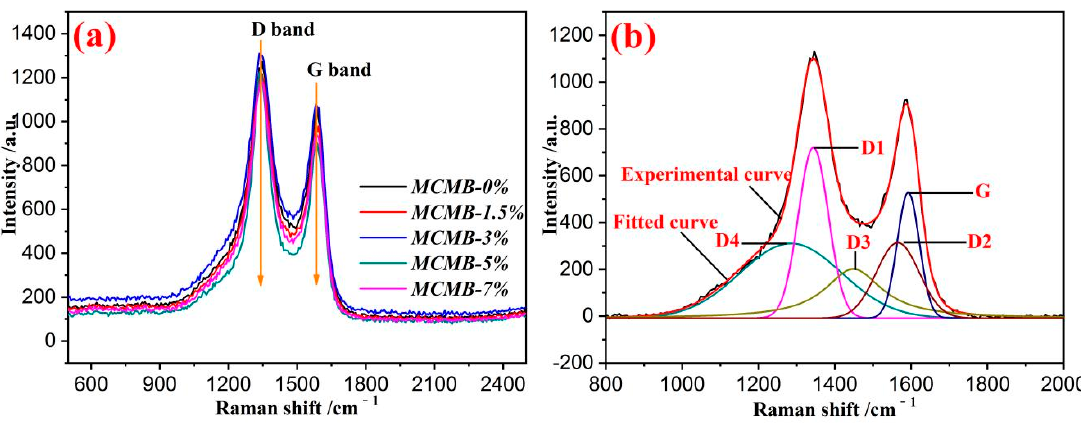
Figure 7. Raman spectrum of MCMBs ( a ) and fitted curve of MCMB-3% ( b ).